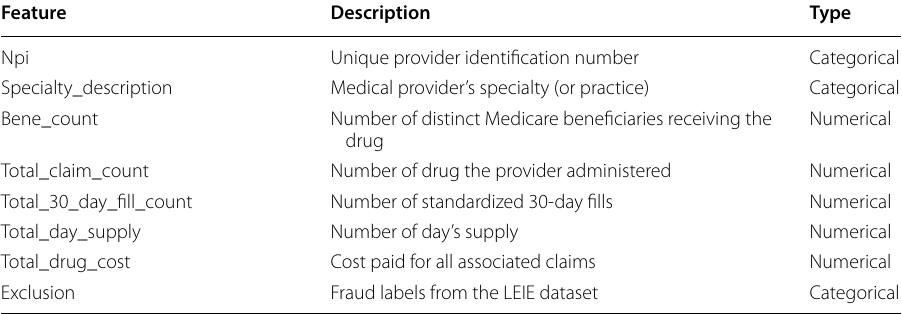
Table 7 Description of features chosen from the Part D dataset Feature